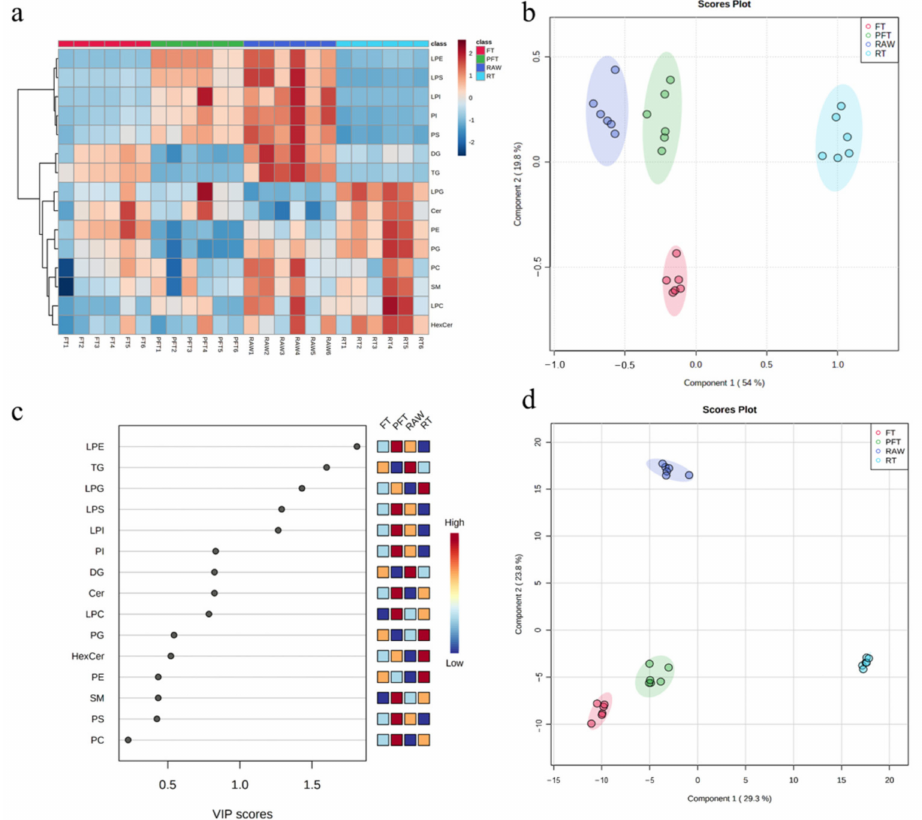
Figure 3. Multivariate statistical analysis of lipids in L. vannamei after low-temperature storage. ( a ) Heatmap of lipid species; each colored cell on the map relates to the peak area value of different lipid species; red indicates high, and blue indicates low. ( b ) PLS-DA score plot of lipid species. ( c ) VIP scores of lipid species in PLS-DA; the colored boxes on the right indicate the relative concentrations of different lipid species; red indicates high, and blue indicates low. ( d ) PLS-DA score plot of individual lipids. Note: RAW: fresh group; RT: refrigerated treatment (4 ◦ C); PFT: particle-freezing